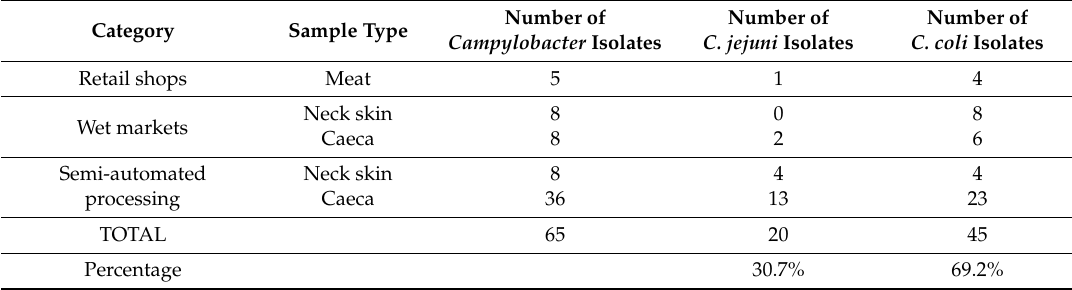
Table 2. Presence of C. jejuni and C. coli among different types of